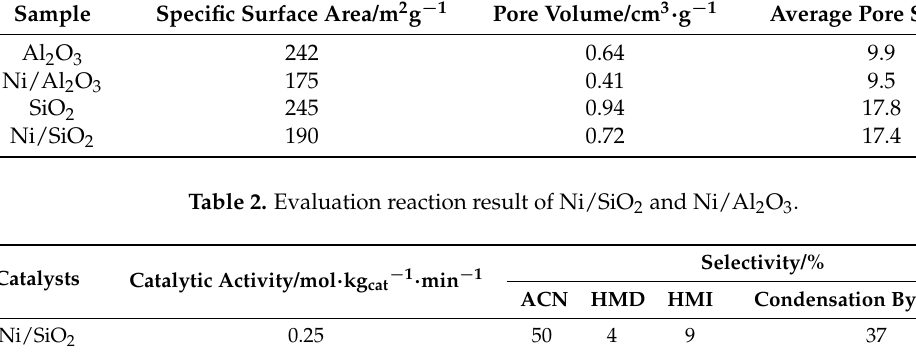
Table 1. Specific surface area and pore structure of the supports and the catalysts.